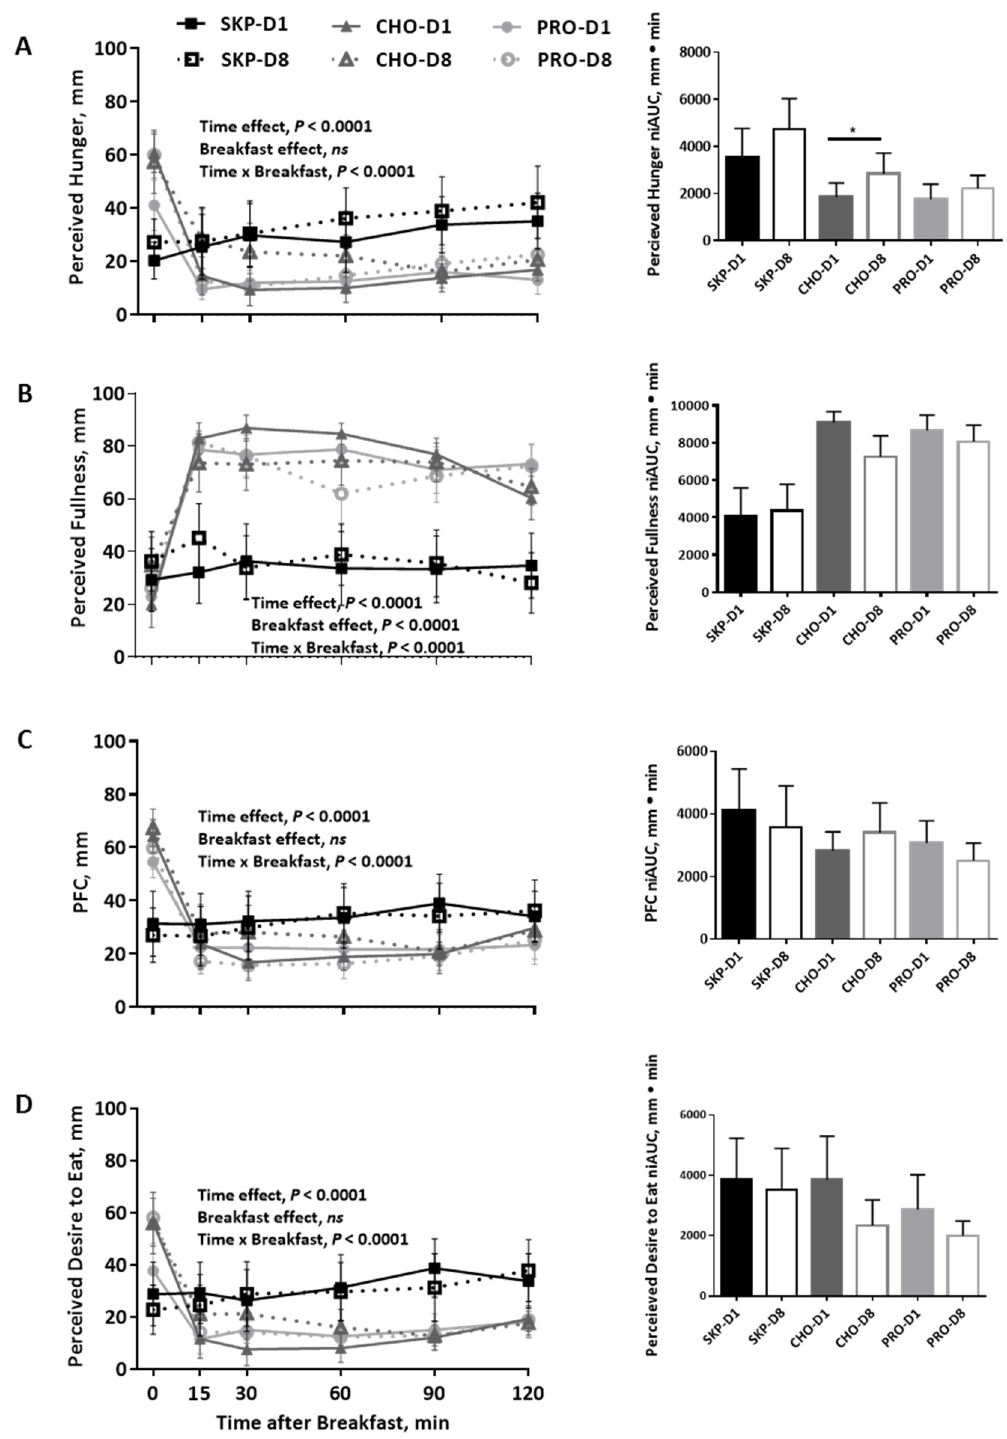
Figure 2. Ratings of appetite two hours postprandial (PP) following a PRO ‐ or CHO ‐ breakfast or continued breakfast skipping using visual analog scales. Data are expressed as means ± SEMs; SKP n = 8, PRO n = 8, CHO n = 8. ( A ) Perceived hunger over time and net incremental area under the curve (niAUC) for perceived hunger for each breakfast group; ( B ) Perceived fullness over time and niAUC for perceived fullness for each breakfast group; ( C ) Prospective food consumption (PFC) over time and niAUC for PFC for each breakfast group; ( D ) Perceived desire to eat over time and niAUC for perceived desire to eat for each breakfast group. * p ≤ 0.05. SKP, breakfast skipping; CHO, carbohydrate ‐ based breakfast; PRO, protein ‐ based breakfast.